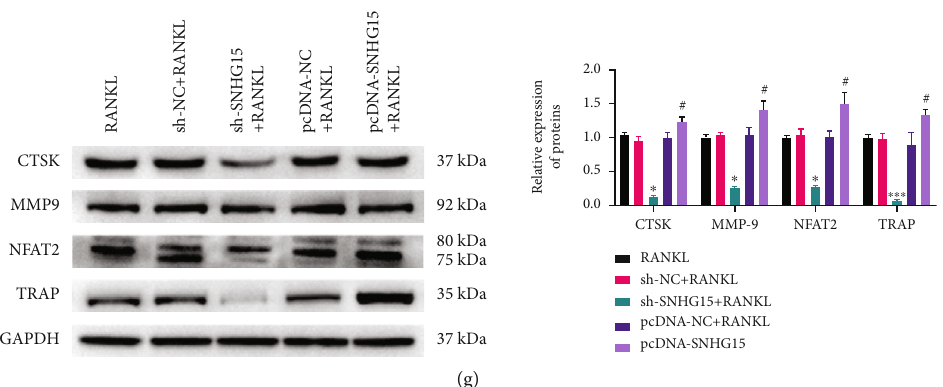
Figure 2: E ff ects of SNHG15 on osteoclast di ff erentiation, proliferation, and movement of osteoclast precursors. (a) The transfection of sh- SNHG15 in 293T cells was detected by RT-qPCR; (b) cell morphology was observed by optical microscope; (c) CCK-8 was used to detect cell proliferation rate; (d) TRAP staining observed osteoclast of THP-1 cells; (e) rhodamine-labeled phalloidin staining observed the positive rate of F-actin. (f) Transwell detected cell migration; (g) Western blot was used to detect proteins expression of osteoclast markers CTSK, MMP- 9, NFAT2, and TRAP. Compared with sh-NC group: & P < 0 : 05 , &&& P < 0 : 001 ; compared with RANKL+sh-NC group: ∗ P < 0 : 05 , ∗∗ P < 0 : 01 , and ∗∗∗ P < 0 : 001 ; compared with RANKL+pcDNA-NC group: # P < 0 : 05 , ## P < 0 : 01 (Figure 3(g)) expression of NEK2 compared with NC mimic group, and knocking down miR-381-3p promoted the mRNA and protein expression of NEK2. Therefore, miR- 381-3p negatively regulated NEK2.